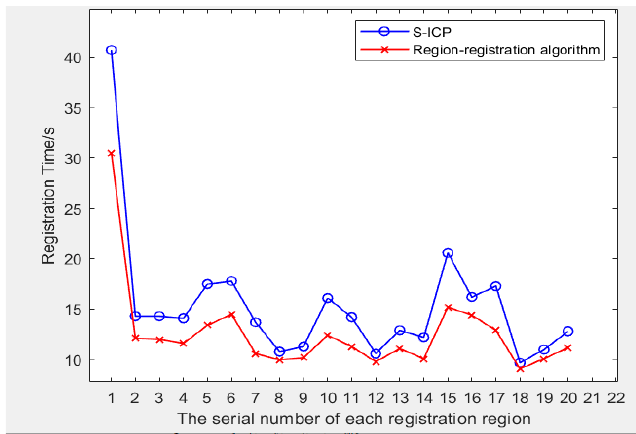
Figure 10. Registration time of each sub-region under two algorithms.